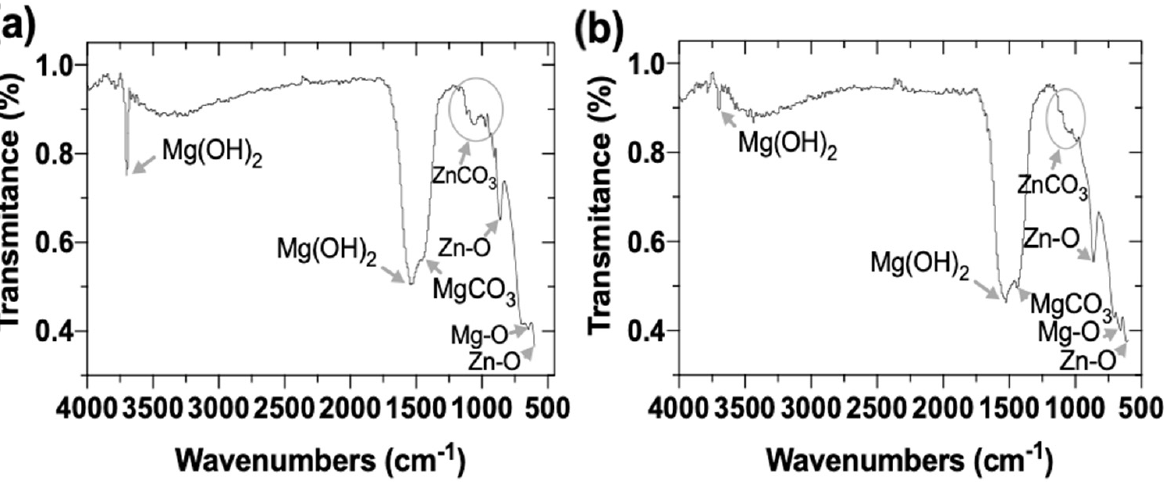
Figure 15. FTIR spectra of the hybrid ZnO/Ag-NPs deposits on Mg–Ca0.3 surfaces, electroless achieved from aqueous suspensions (10 − 3 M, at 21 °C): ( a ) ZnO/AgNO 3 and ( b ) Zn(NO 3 ) 2 /AgNO.